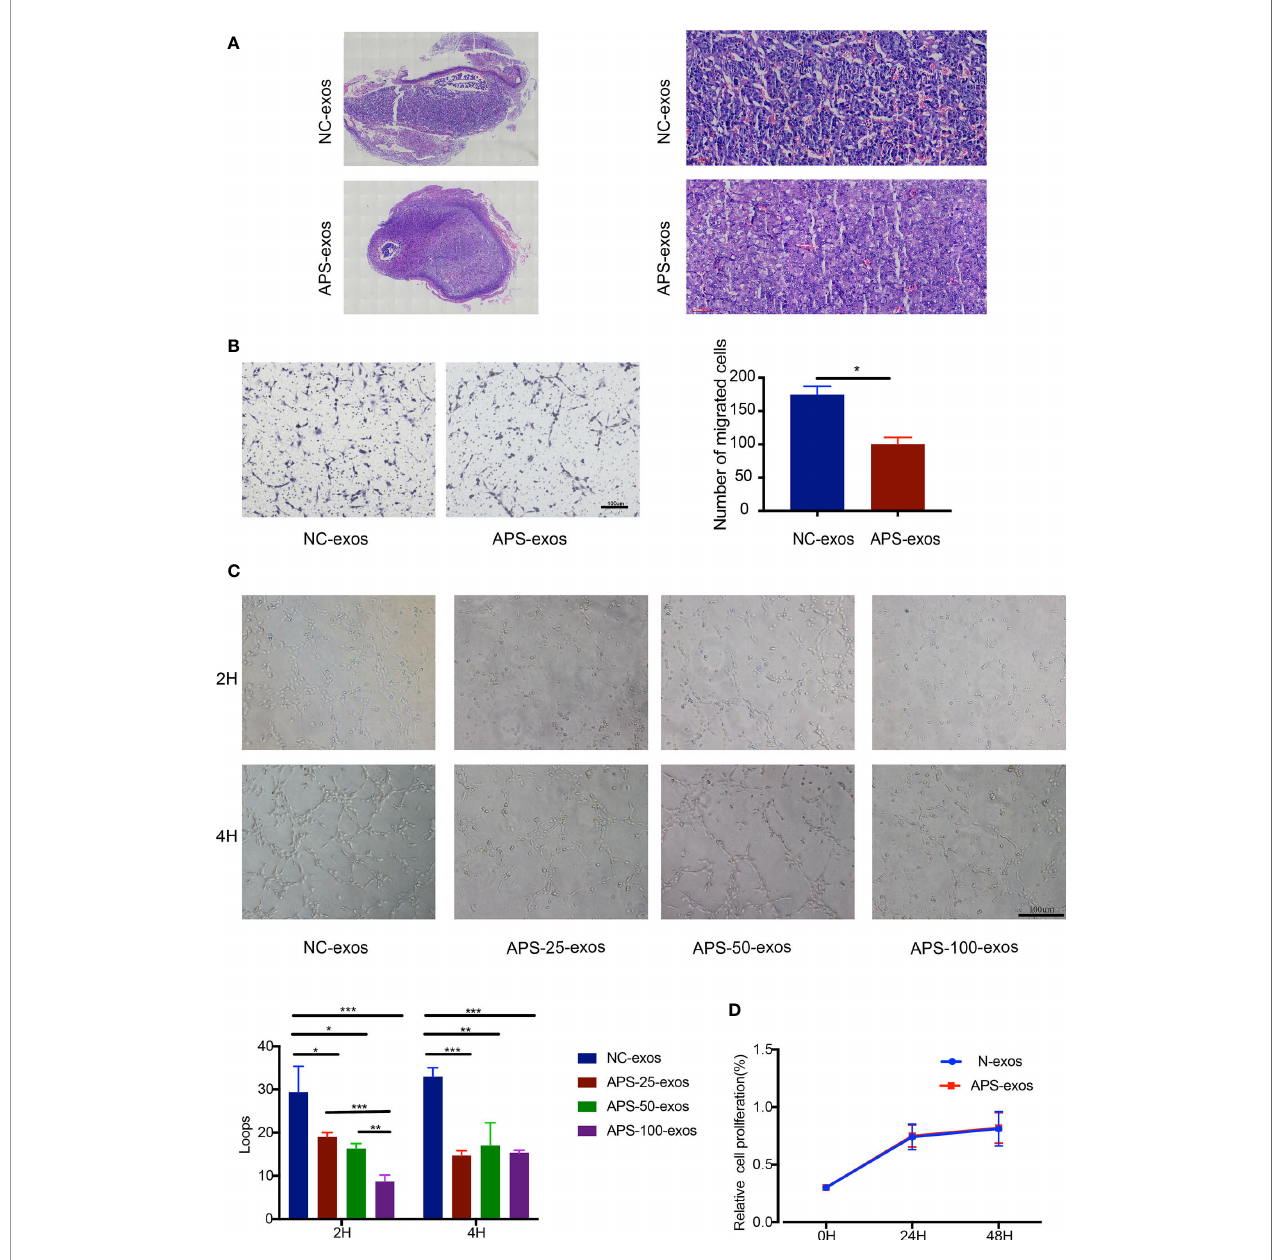
FIGURE 2 | (A) Pathological analysis of hematoxylin and eosin (H&E)-stained placental tissue. H&E staining of placental tissue from the antiphospholipid syndrome- exosomes (APS-exos) and normal control (NC)-exos mouse model analyzed by light microscopy (2× and 20×). Placental blood vessels in mice treated with APS- exos compared with those treated with NC-exos. (B) After incubation with APS-exos or N-exos (50 m g/ml) for 16 h, human umbilical vein endothelial cell (HUVEC) migration was analyzed. *P = 0.029 by Paired t test. (C) After incubation with NC-exos (50 m g/ml) or APS-exos (25 m g/ml, 50 m g/ml, 100 m g/ml) for 2 h and 4 h, angiogenesis of HUVECs was analyzed. *P < 0.05; **P < 0.01; ***P < 0.001 by t test. (D) After incubation with APS-exos/NC-exos (50 m g/ml) for 24h and 48h, HUVEC proliferation was analyzed by the cell counting kit-8 assay. *P = 0.183 by Paired t test. All data shown as mean ±